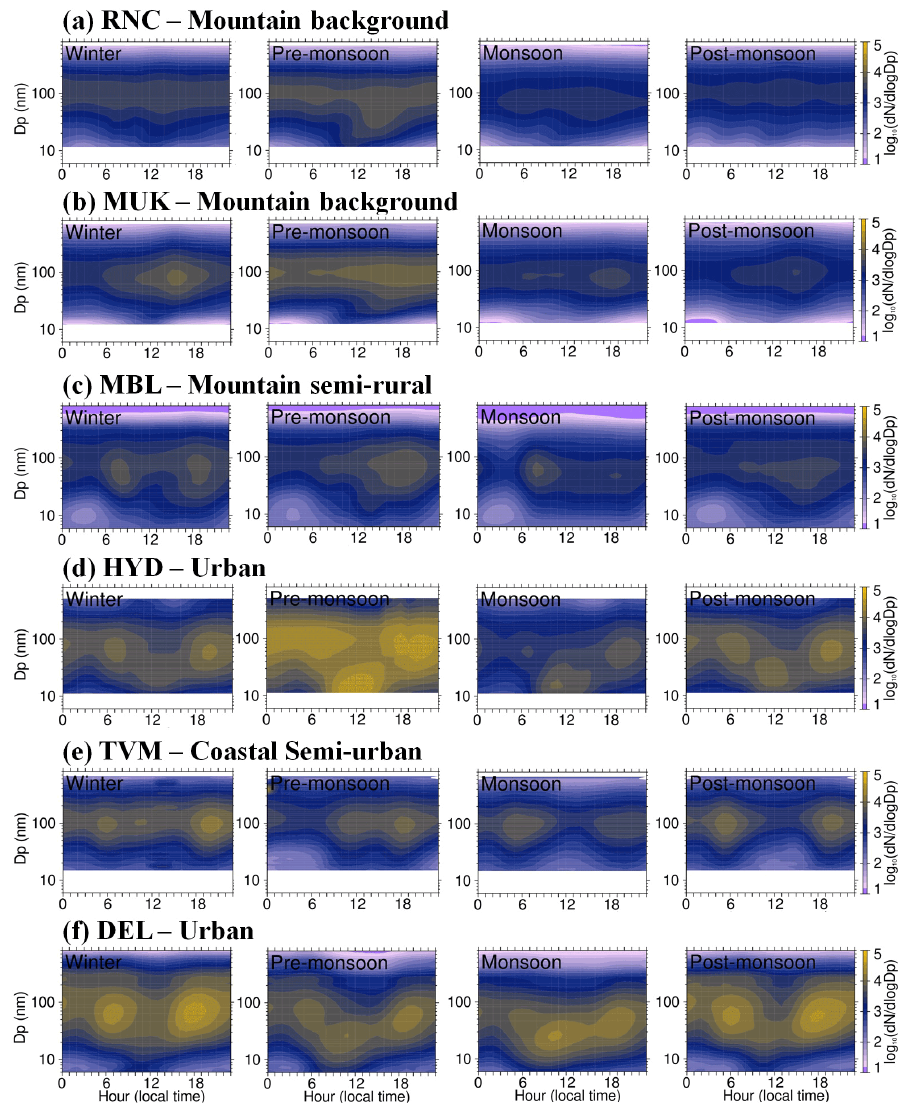
Figure 4. The diurnal–seasonal median particle number size distributions at all the sites: (a) Ranichauri, (b) Mukteshwar, (c) Mahabaleshwar, (d) Hyderabad, (e) Thiruvananthapuram, and (f) Delhi. Note that measurements are from different time periods for each site (see Table